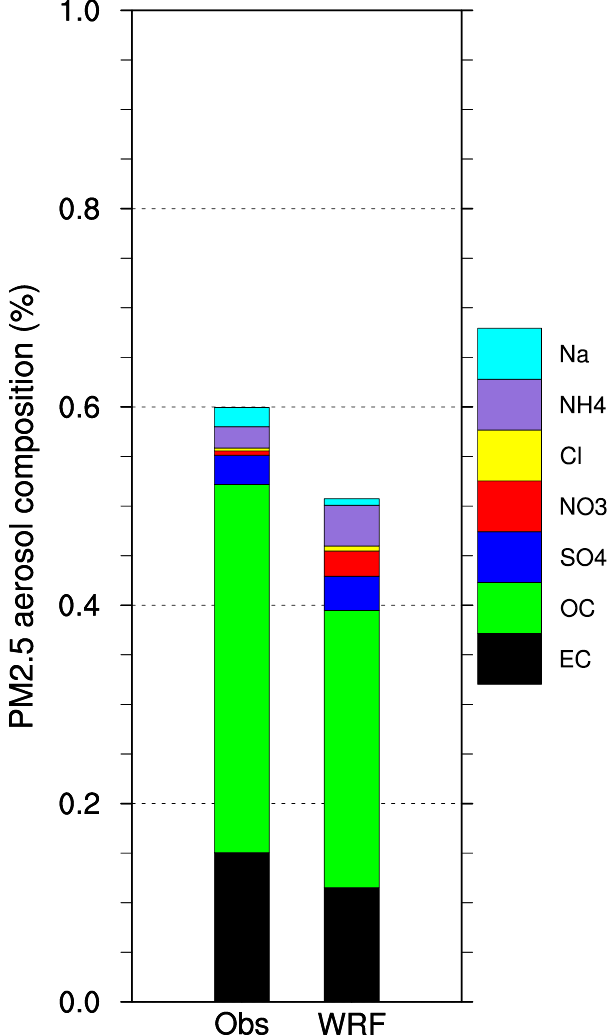
Figure 16. The observed and predicted average contributions for the main identified constituents of PM 2 . 5 at